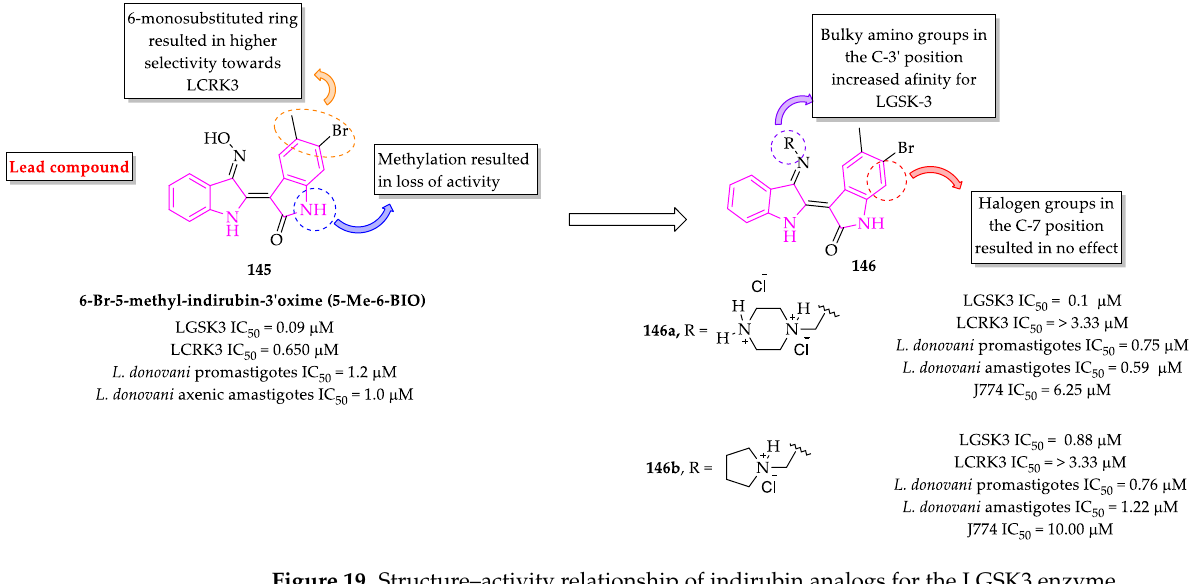
Figure 19. Structure – activity relationship of indirubin analogs for the LGSK3 enzyme. Aiming to obtain new inhibitors of dihydrofolate reductase (DHFR), another enzyme important for the parasite survival, Chauhan ’s group planned a molecular hybridization approach, joining a 1,3,5-triazine or pyridine unit to the [1,2,4]triazino[5,6- b ] indole moiety (Scheme 12). This strategy resulted in 22 hybrids that were subjected to in vitro biological evaluation against L. donovani parasites [111]. The results showed triazine derivatives ( 150 ) were more potent than the corresponding pyrimidine analogs, particularly the triazine derivative with R 1 = piperidine ( L. donovani IC 50 = 4.01 µ M, J774.A1 CC 50 = of 227.04 µ M), which was 20- to 10-fold more selective than standard drugs such as pentamidine and sodium stibogluconate [111]. Subsequently, the same research group developed a series of [1,2,4]triazino[5,6- b ] indole hybrids ( 151 ) with 4-amino-7-chloroquinoline. Changing the linker size, the protection group attached to the nitrogen atom of the indole moiety and the nature of substituent in the position C-6 or C-8 of the aromatic ring, the authors were able to identify some lead compounds with high antileishmanial activity and low cytotoxicity. It also was observed that compounds with a linker size of two carbon atoms and with a small alkyl group at nitrogen atom or unsubstituted aromatic ring produced a very potent hybrid for both promastigotes and intracellular amastigotes [112].